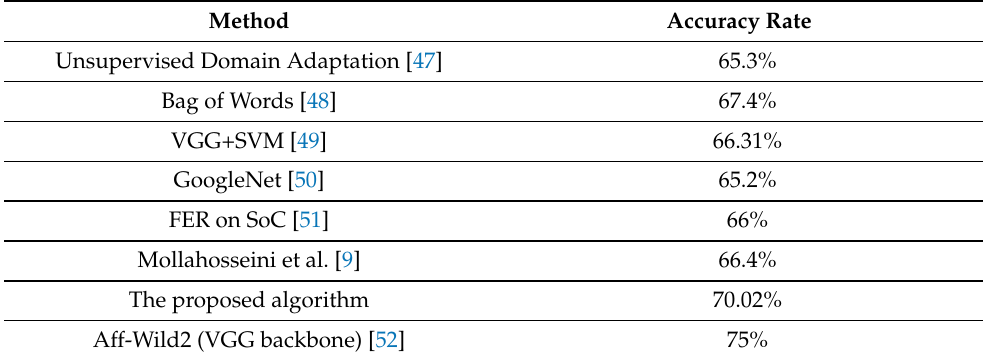
Table 1. Classification accuracies on the FER 2013